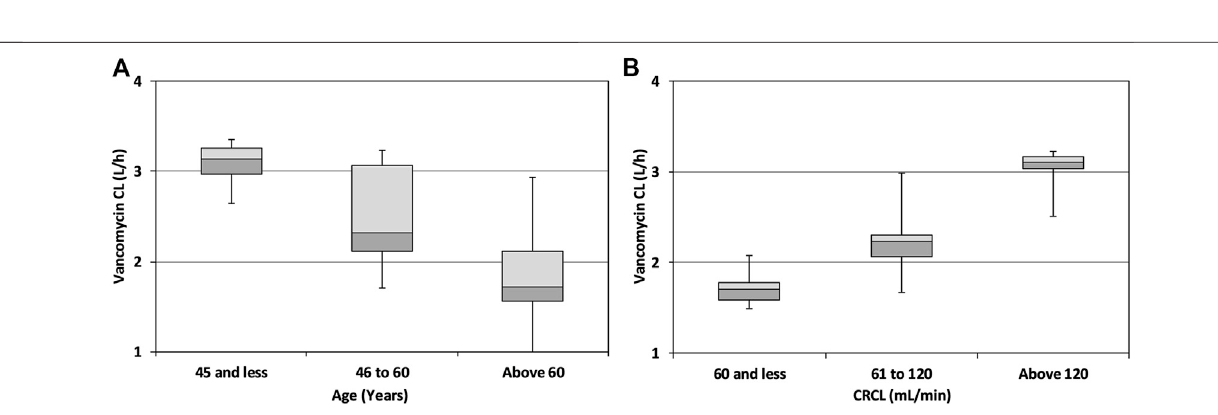
Frontiers in Pharmacology |